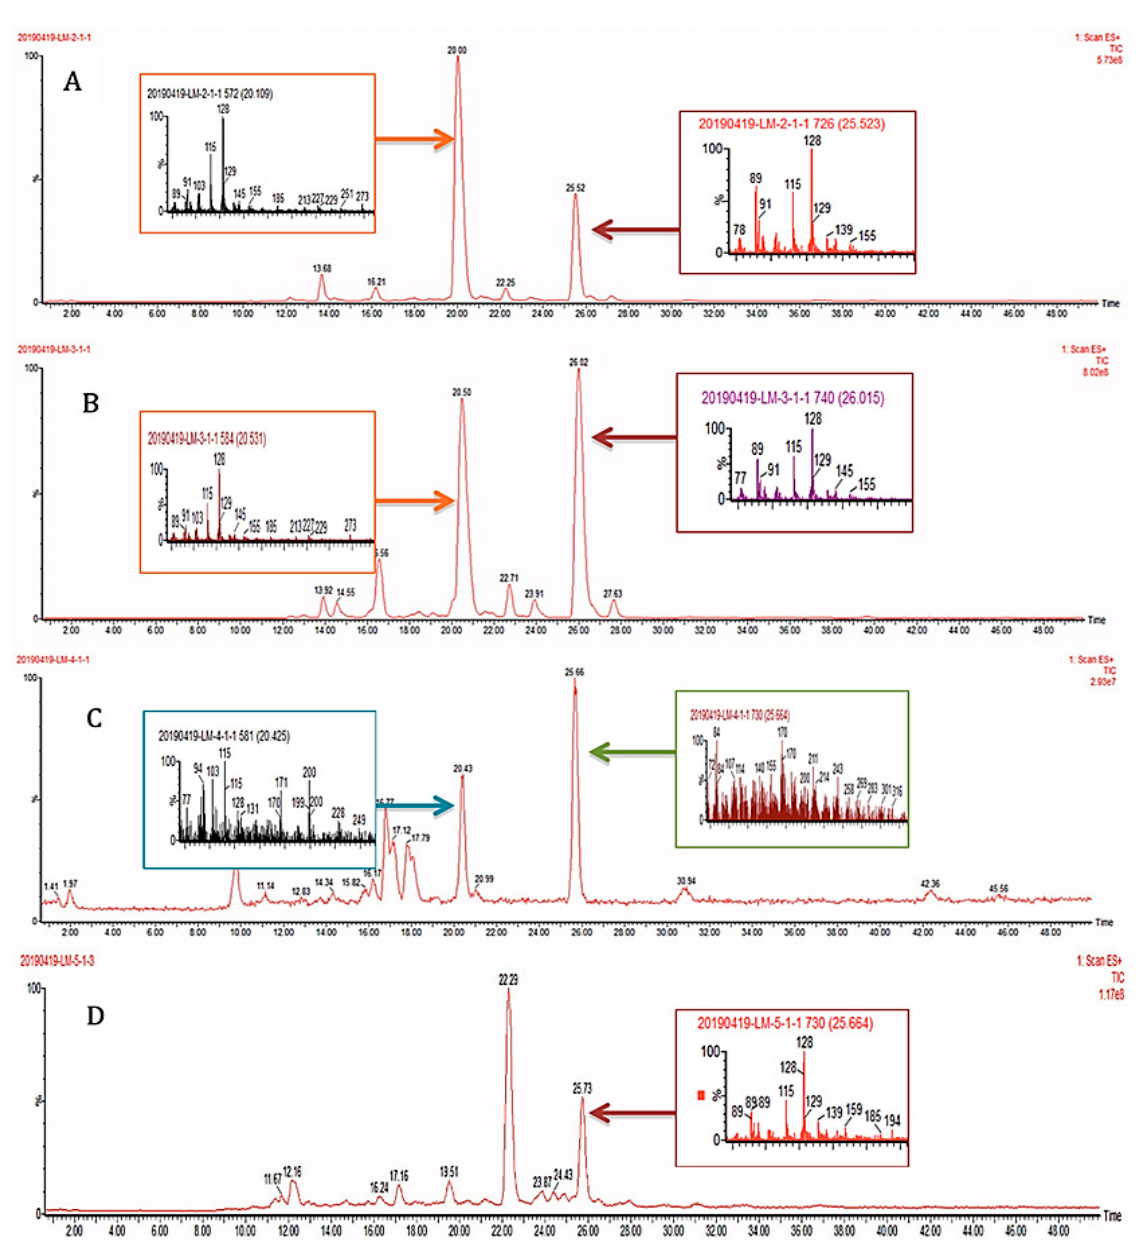
Figure 2. HPLC-MS profiles of ( A ) healthy and ( B ) predated leaves of A. cathartica and ( C ) caterpillar bodies and ( D ) caterpillar feces.